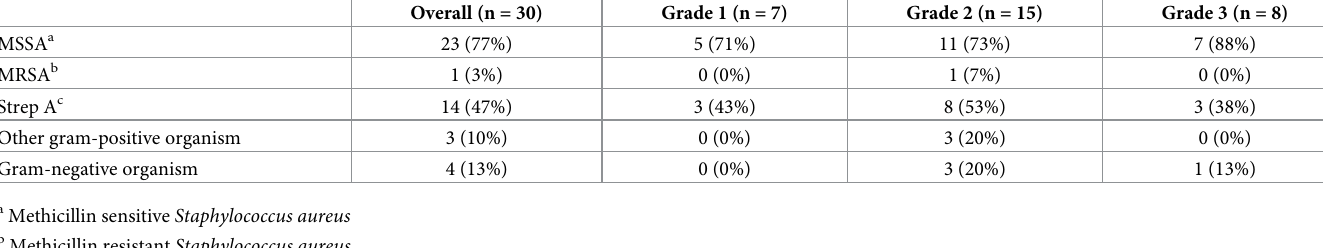
Table 3. Skin swab isolates in episodes with crusted